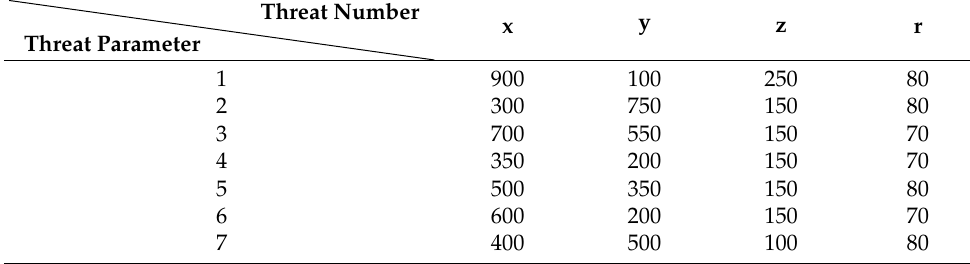
Table 3. Threats parameter